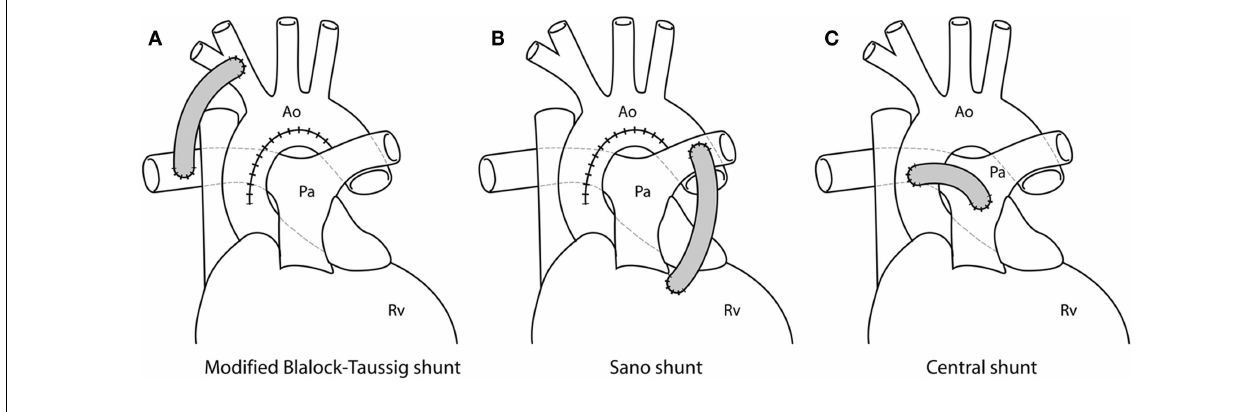
FIGURE 1 | Different shunting options for first stage palliation of HLHS, shown from idealized drawings: (A) modified Blalock-Taussig shunt from the innominate artery to the right pulmonary artery;